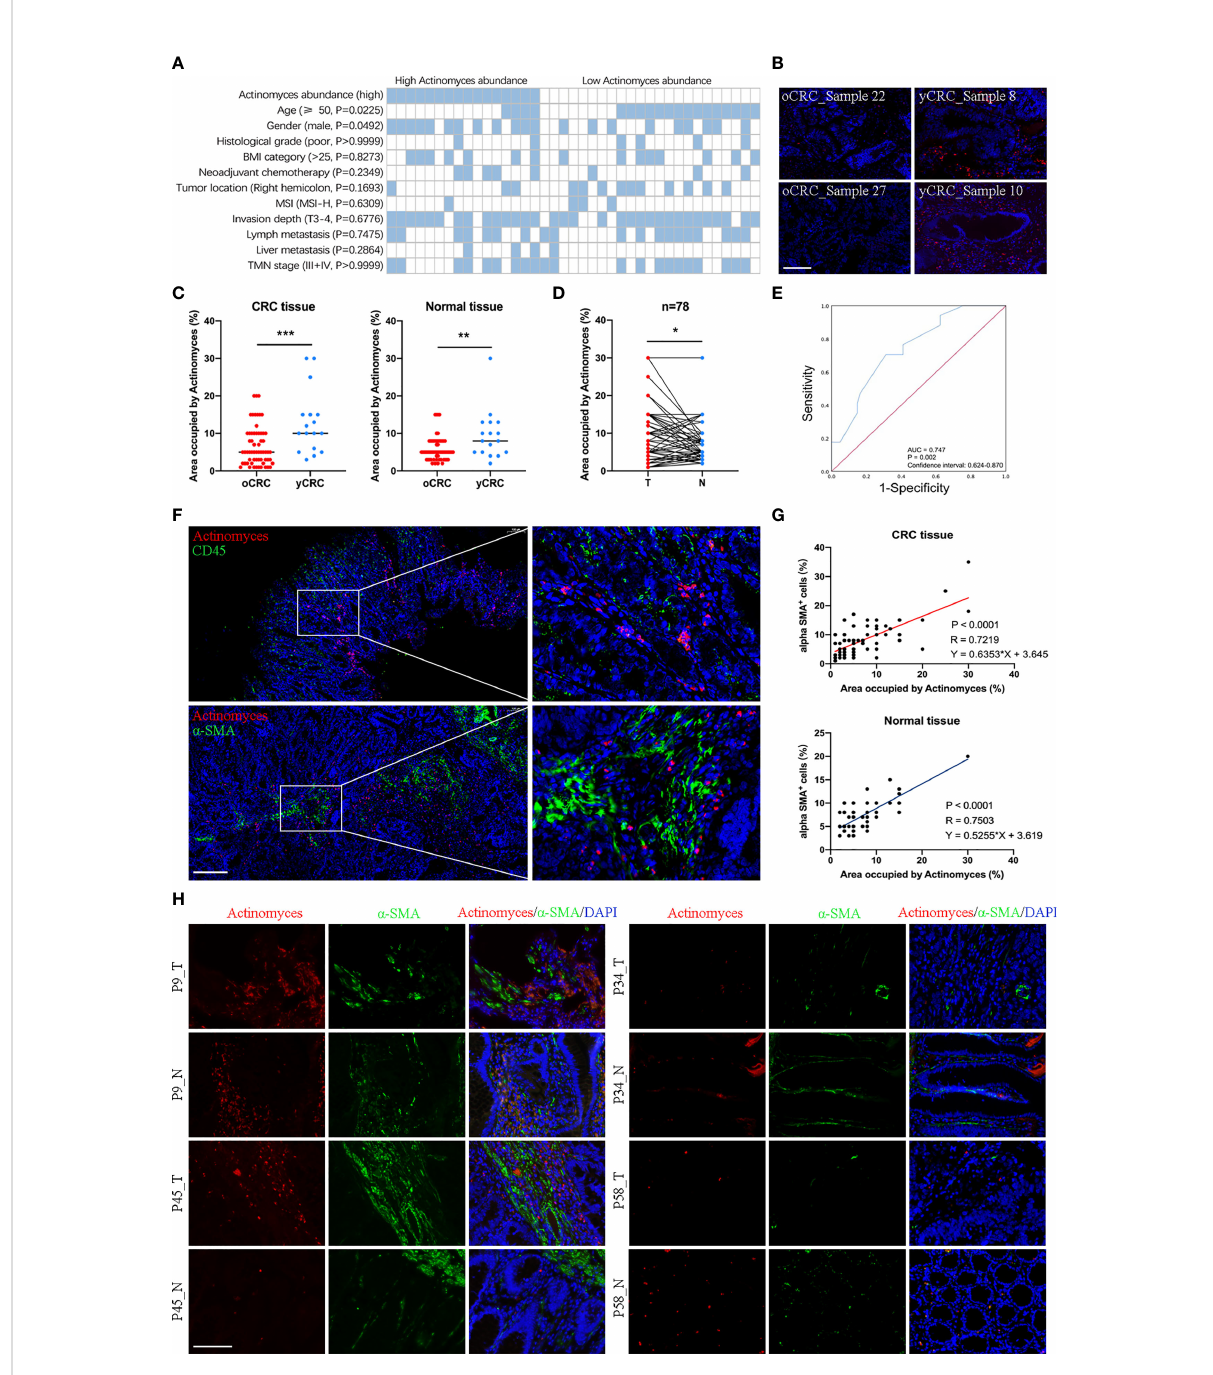
FIGURE 5 Localization of Actinomyces in CRC. (A) Heatmap shows clinical characteristics of 39 patients for 16S rRNA sequencing analysis. Statistical signi fi cance was analyzed by the c 2 test. P values are as indicated. (B) Actinomyces staining in human CRC tissues. Fluorescence in situ hybridization (FISH) analysis revealed the presence of punctate bacteria (red) in yCRC tissues. Scale, 100 m m. (C) The area occupied by Actinomyces was evaluated by FISH. Abundance of Actinomyces in yCRC was higher than that in oCRC (mean ± SD, Student ’ s t-test, **P<0.01, ***, p < 0.001). (D) Abundance of Actinomyces in CRC tissues was slightly higher than that in normal tissues (mean ± SD, Student ’ s t-test, *P<0.05). (E) Receiver operating characteristic curves (ROC) of oCRC vs . yCRC in validation set (n = 78). Area under the curve (AUC) values for prediction of oCRC and yCRC using Actinomyces markers. (F) FISH analysis revealed the localization of Actinomyces in CRC. Most of the positively stained bacteria were enriched in cancer-associated fi broblasts ( a -SMA+), and a few co-localized with immune cells (CD45+). Scale, 200 m m. (G) The proportion of a -SMA+ cells was positively correlated with abundance of Actinomyces in CRC tissues and normal tissues. (H) FISH and IHC staining in human CRC tissues and normal tissues. Red, Actinomyces probe. Green, a -SMA. Scale, 100 m